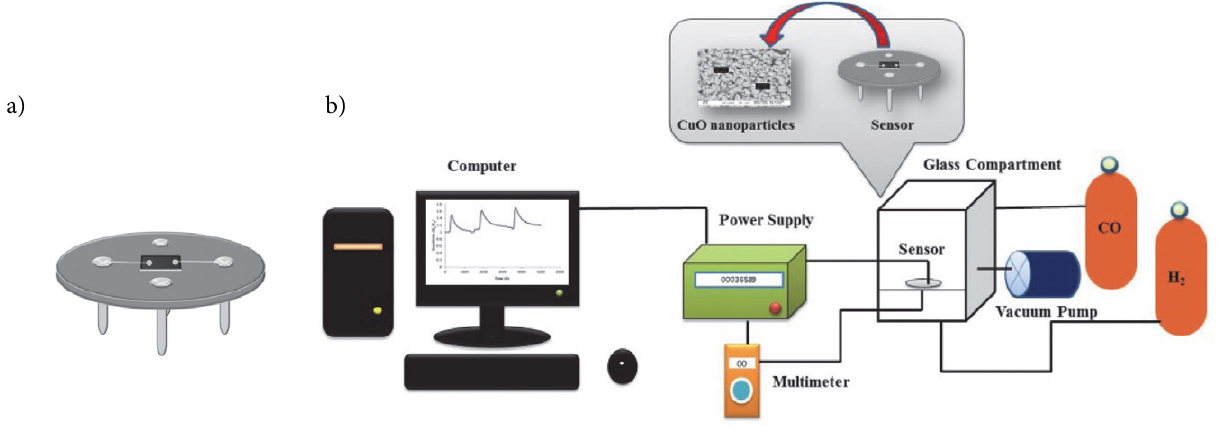
Figure 2 . Schematic image of (a) sensor kit, and (b) the gas-sensing analysis